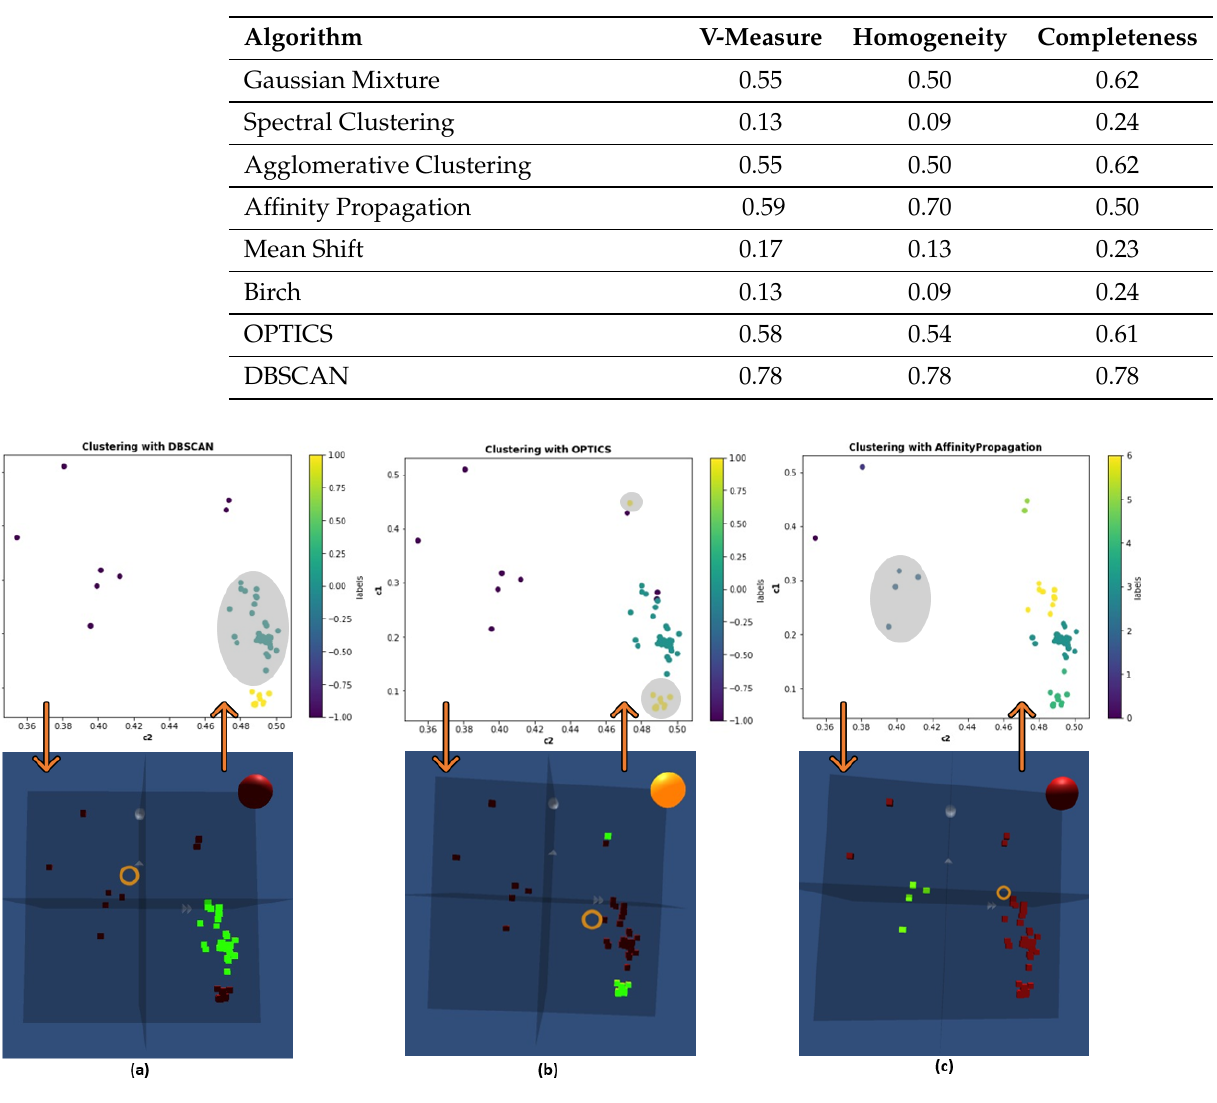
Figure 2. Comparison of clustering results obtained with selected algorithms: ( a ) DBSCAN; ( b ) OPTICS; ( c ) Affinity Propagation. The top row presents the 2D plots, whereas the bottom one shows 3D scatter plots as the headset wearer sees them. The selected clusters are marked gray hulls (in 2D) and green (in 3D), respectively. These clustering examples were done over the DS1